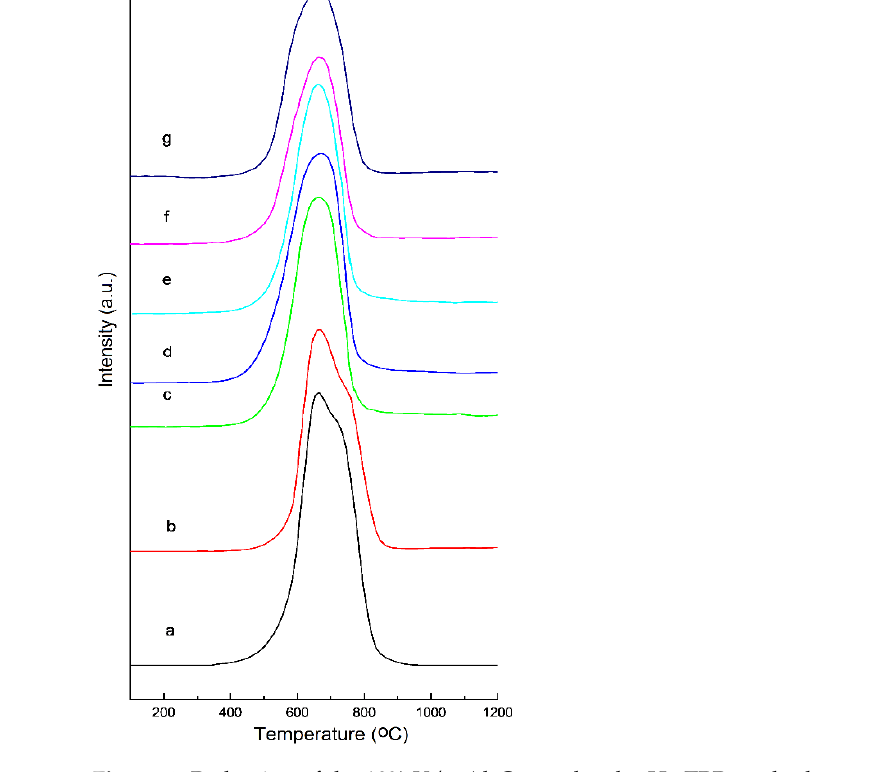
Figure 4. Reduction of the 10% V/ γ -Al 2 O 3 catalyst by H 2 -TPR method at varying the preheating temperature in air. ( a ) 25 °C; ( b ) 300 °C; ( c ) 400 °C; ( d ) 500 °C; ( e ) 600 °C; ( f ) 700 °C; ( g ) 800 °C.